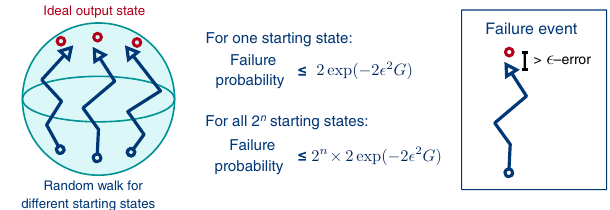
FIG. 5. Illustration of the probabilistic proof for the com- muting Hamiltonian given in Eq. (16). We consider all the 2 n computational basis states as the starting state. The probability for one of the starting state to incur at least an error (cid:2) is expo- nentially smaller than the probability for the maximum of the 2 n starting states to incur error > (cid:2) . However the failure probability is exponential suppressed by increasing the gate count N .